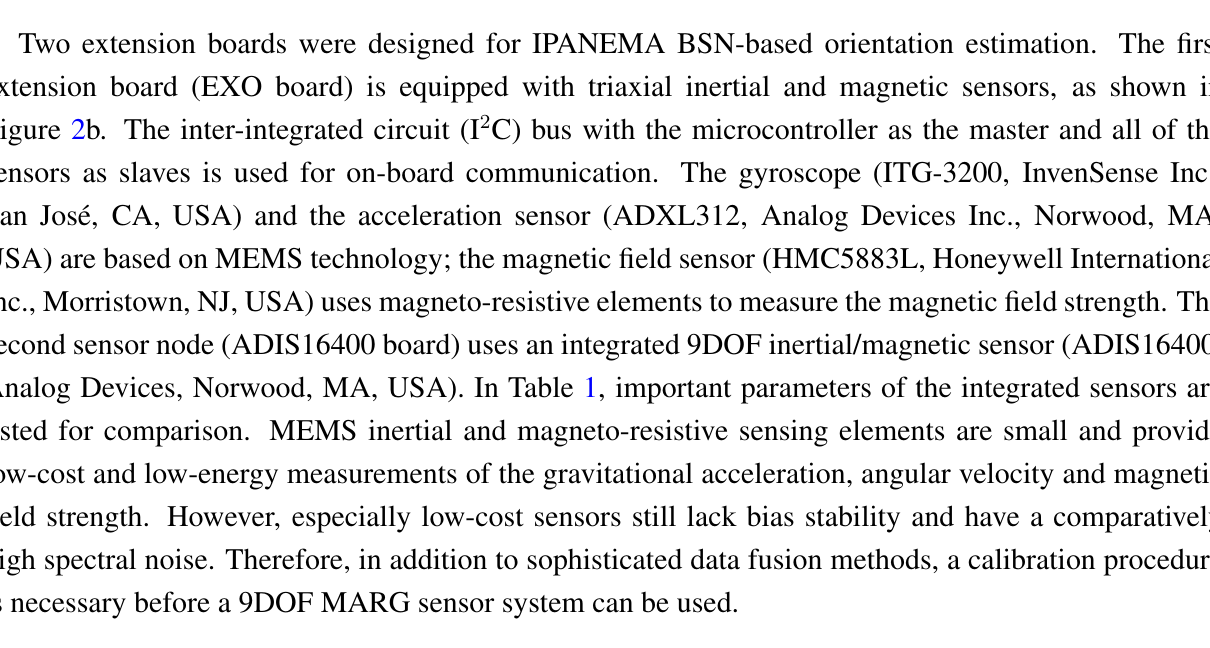
Table 1. Specifications of both the reference and proposed BSN-integrated magnetic, angular rate and gravity (MARG) sensor system in